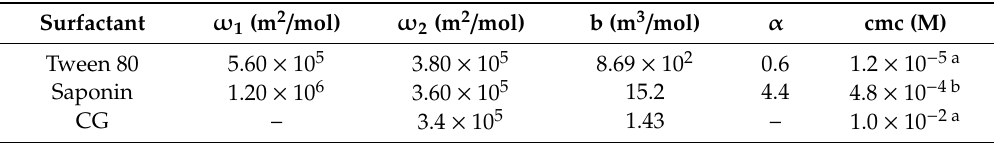
Table 1. Adsorption isotherm parameters corresponding to the best fit curves reported in Figure 4 and critical micellar concentration,